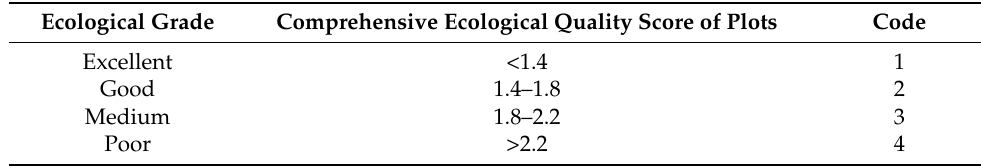
Table 4. Classification criteria for the four ecological grades of plots. Ecological Grade